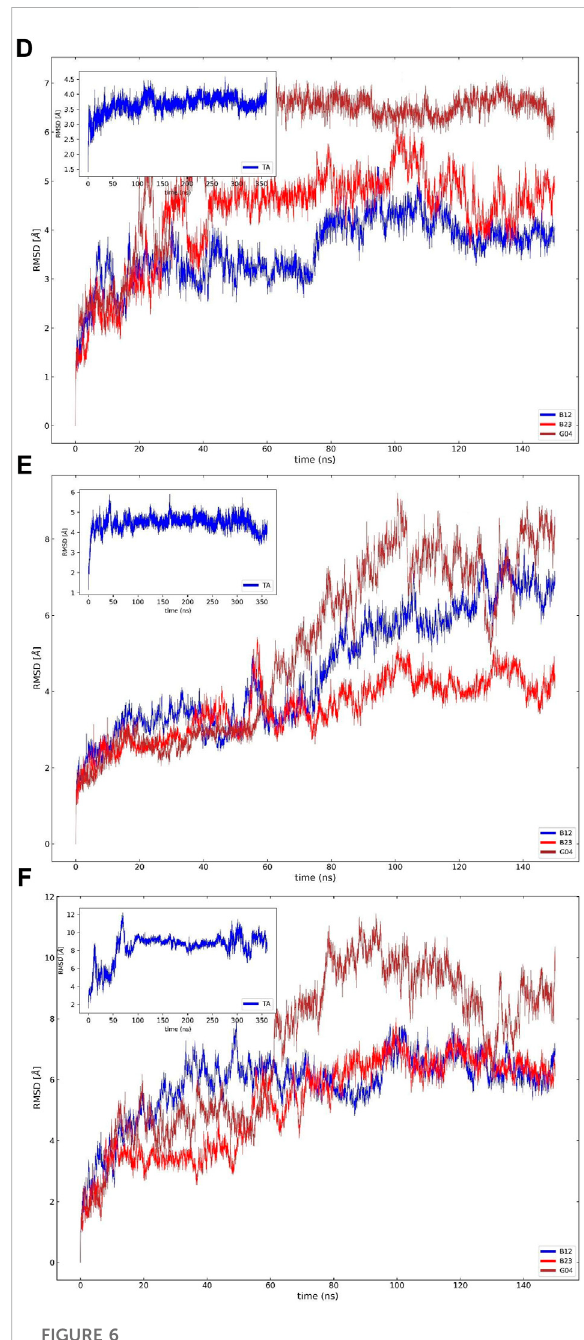
FIGURE 6 (Continue). Conformational analysis of the TyrR bound to the selected EOs compounds. (A) Overall RMSD of the protein bound to the EO compounds and TA as referenced ligand, showing in a separate subplot, and (B) the corresponding RMSF plot, highlighting the fl uctuation of EL1, El2, and IL3 in blue, green, and yellow, respectively. (C) The average RMSD of backbone atoms in EL1, (D) IL2, (E) IL3, and (F) IL4 are also presented. In each plot, the corresponding RMSD for each El and IL calculated from FM simulation are depicted as